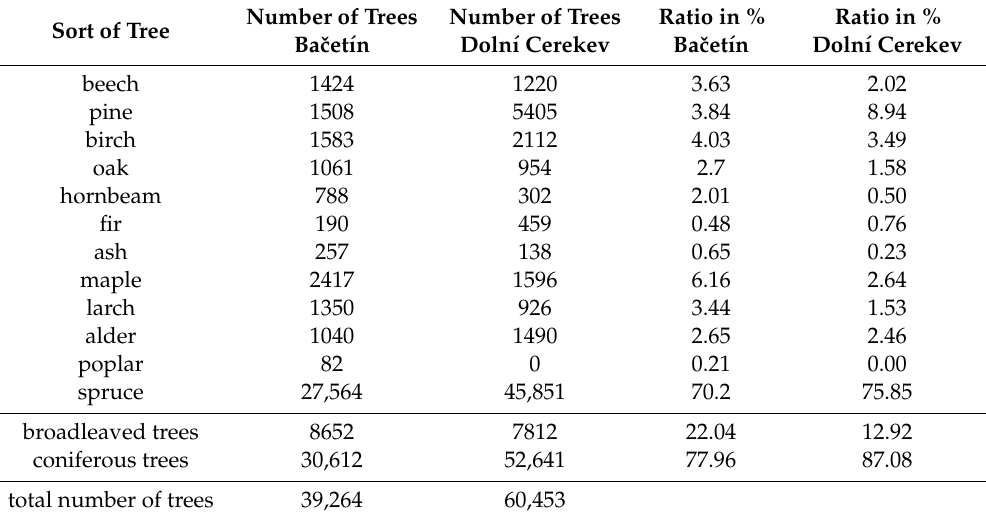
Table 1. The sort of trees and their number occurring in the tested areas; first number is from the Baˇcet í n locality; second number is from the locality Doln í Cerekev